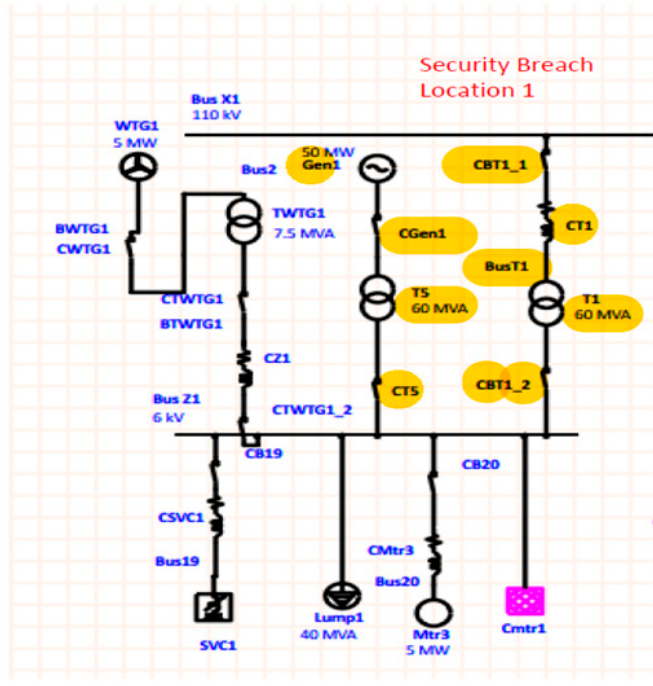
Figure 4. Security breach—Location 1.